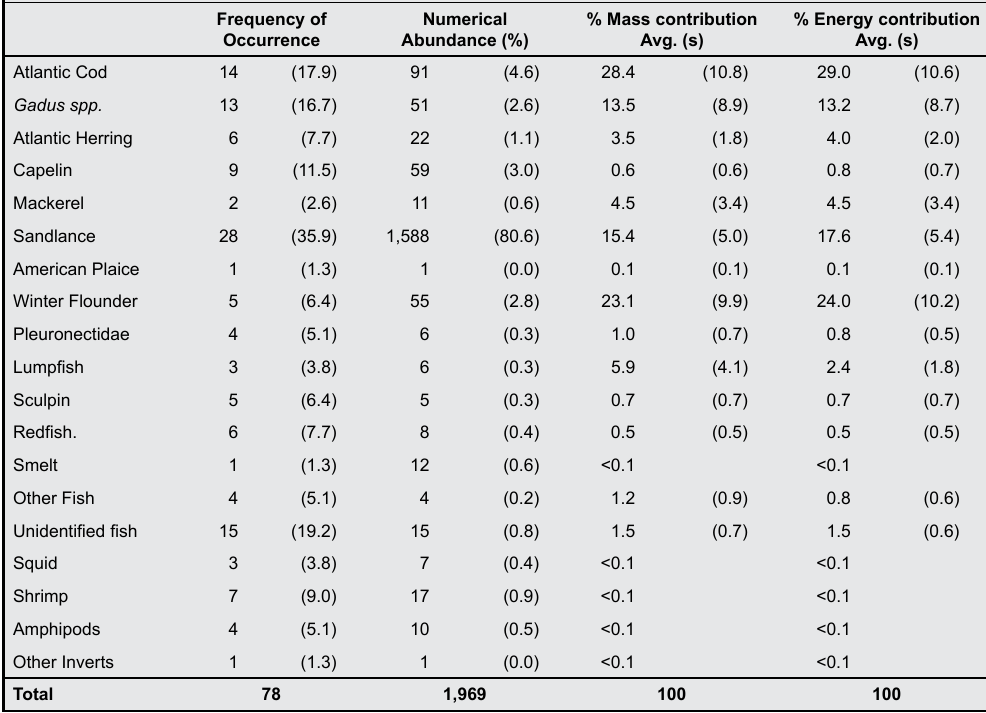
Table 10. Diet composition of 78 seals collected from the west coast of Newfoundland between 1985 and 2004. Frequency of occurrence and % frequency of occurrence in parentheses, numeri- cal abundance with relative percent in parenthesis, and percent (%) mass and energy contribu- tion to the diet with average and standard deviation in